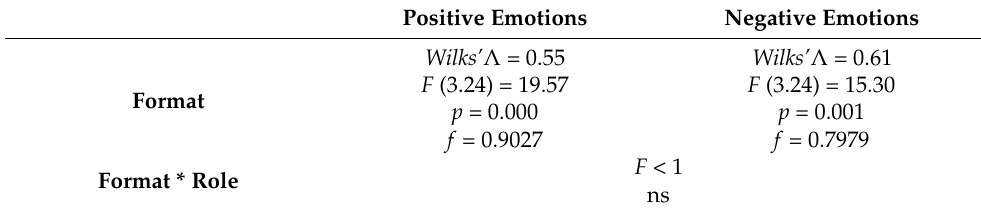
Table 3. Results of analysis of variance (MANOVA) for the factors format and